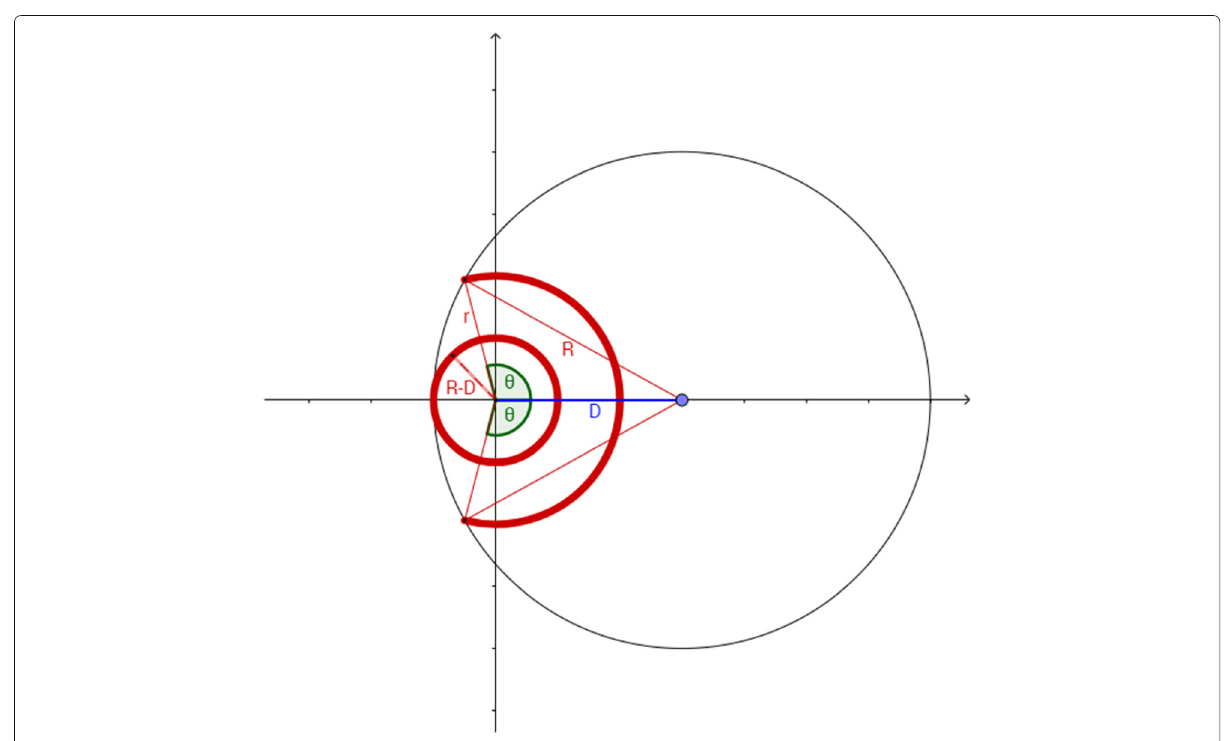
Fig. 18 Integration over a inscribing disk